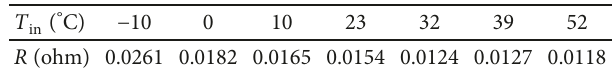
Figure 6: Schematic diagram of the battery operation platform (adapted from [41]). Table 2: Battery R under di ff erent T